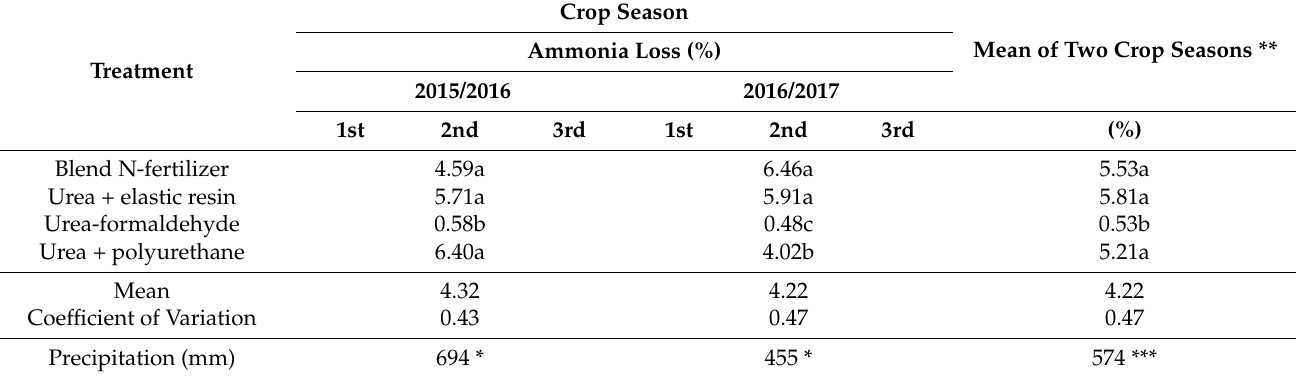
Table 5. Mean accumulated losses of ammonia (% of applied N), for slow-release and controlled- release N fertilizers, in one single application in the coffee plantation, during the 2015/2016 and 2016/2017 crop